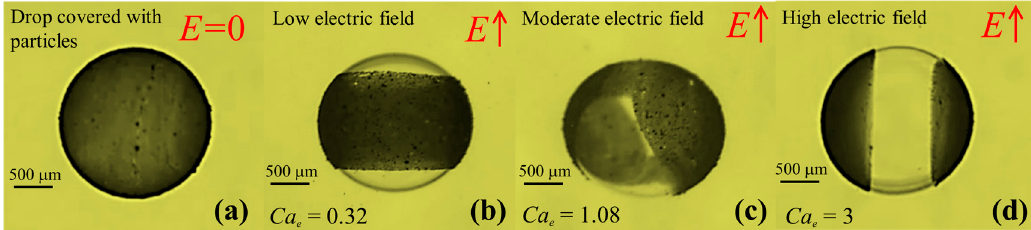
Figure 6. The formation of the particle-covered droplet and the e ff ect of the electric capillary number